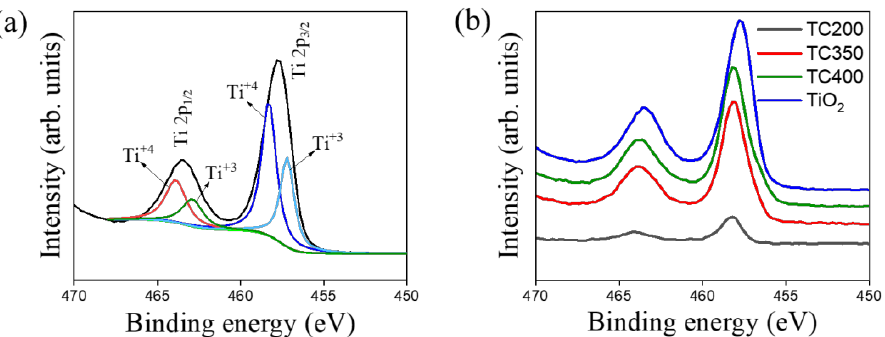
Figure 7. High-resolution XPS Ti 2p spectra: ( a ) TiO 2 and ( b ) comparison of Ti 2p spectra of various samples.